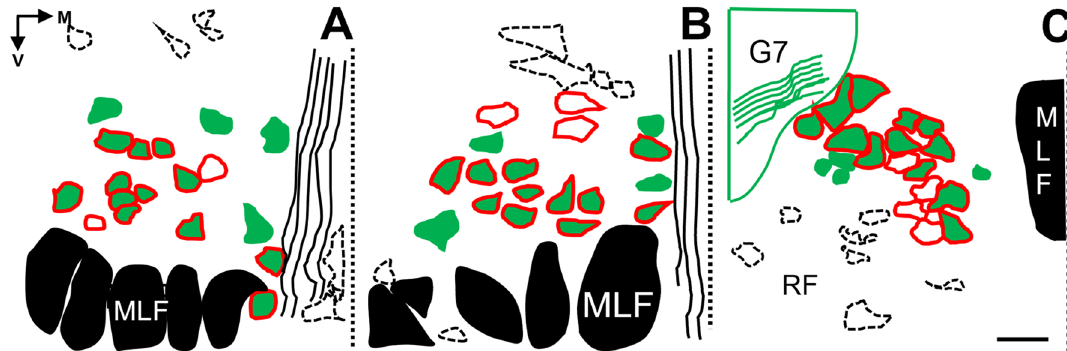
Figure 6. Topographical reconstruction of PNN-bearing- and non-PNN-bearing cholinergic motoneurons in the oculomotor- ( A ), trochlear- ( B ), and abducens nuclei ( C ). In ( A ) and ( B ), PNN bearing motoneurons are evenly distributed in the nuclei, whereas PNN non-bearing motoneurons concentrate in their medial aspects, or are loosely scattered centrally, dorso-medially and dorso-laterally. In C , PNN coated cholinergic neurons are densely fitted adjacent to each other, whereas non-PNN coated motoneurons are irregularly scattered in the nucleus or in its periphery. MLF: medial longitudinal fasciculus. V: ventral. M: medial. G7: facial genu. RF: reticular formation. Dotted line: midline. Frames of interrupted lines represent CSPG densities of non- cholinergic structures in periaqueductal gray matter ( A , B ) or pontine RF ( C ). PNN coated but non-cholinergic neurons are also indicated. Scalebar: 50 µm.